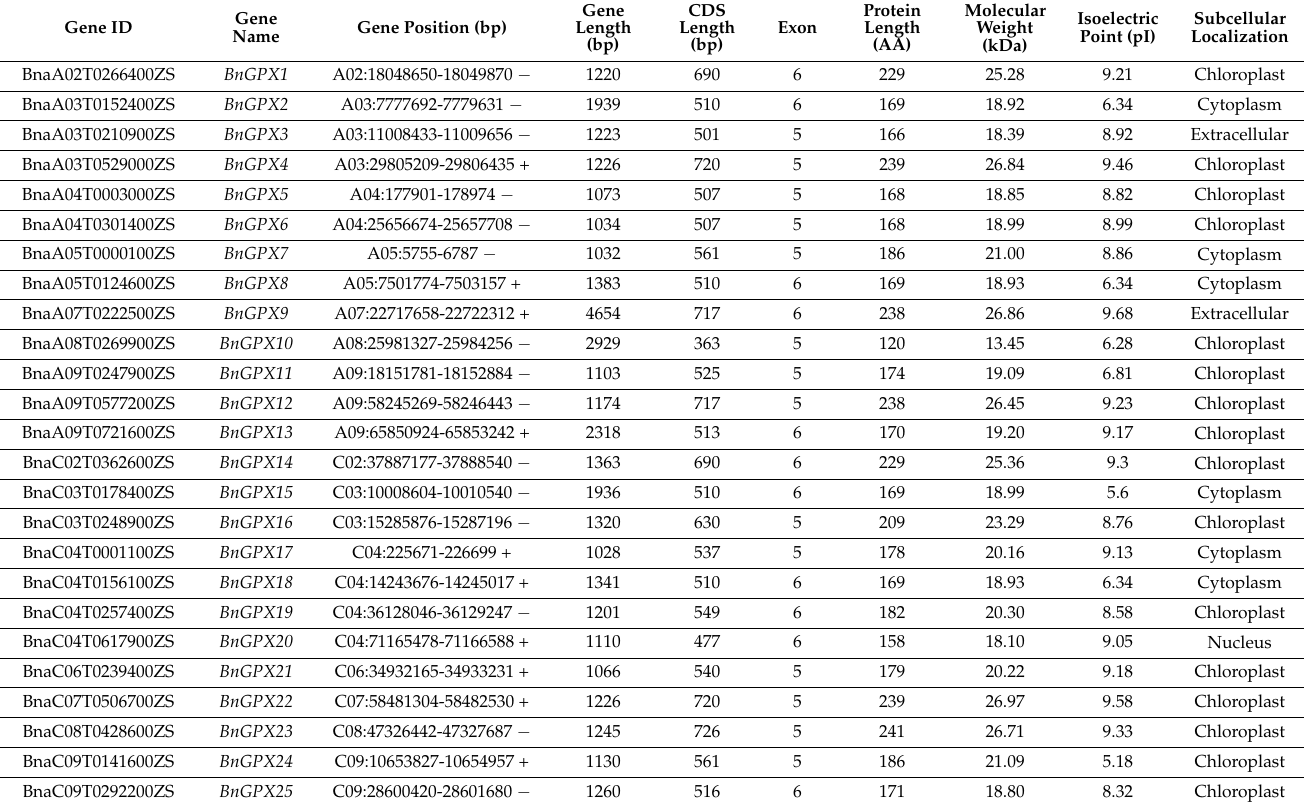
Table 1. Information of the 25 BnGPX genes discovered in rapeseed